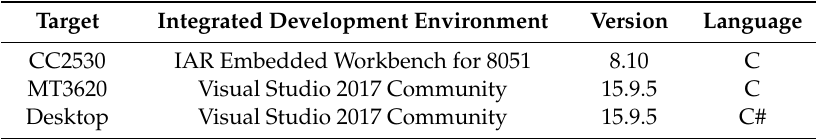
Table 5. Prerequisites for software design in the